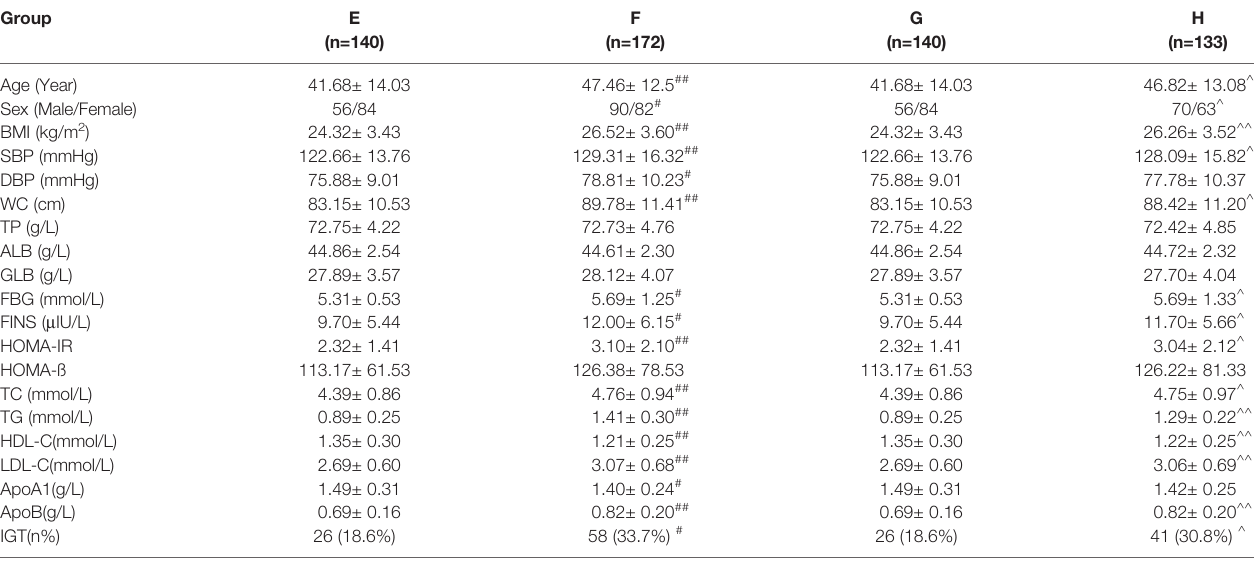
TABLE 5 | Basic parameters and incidence of IGT in subjects with different